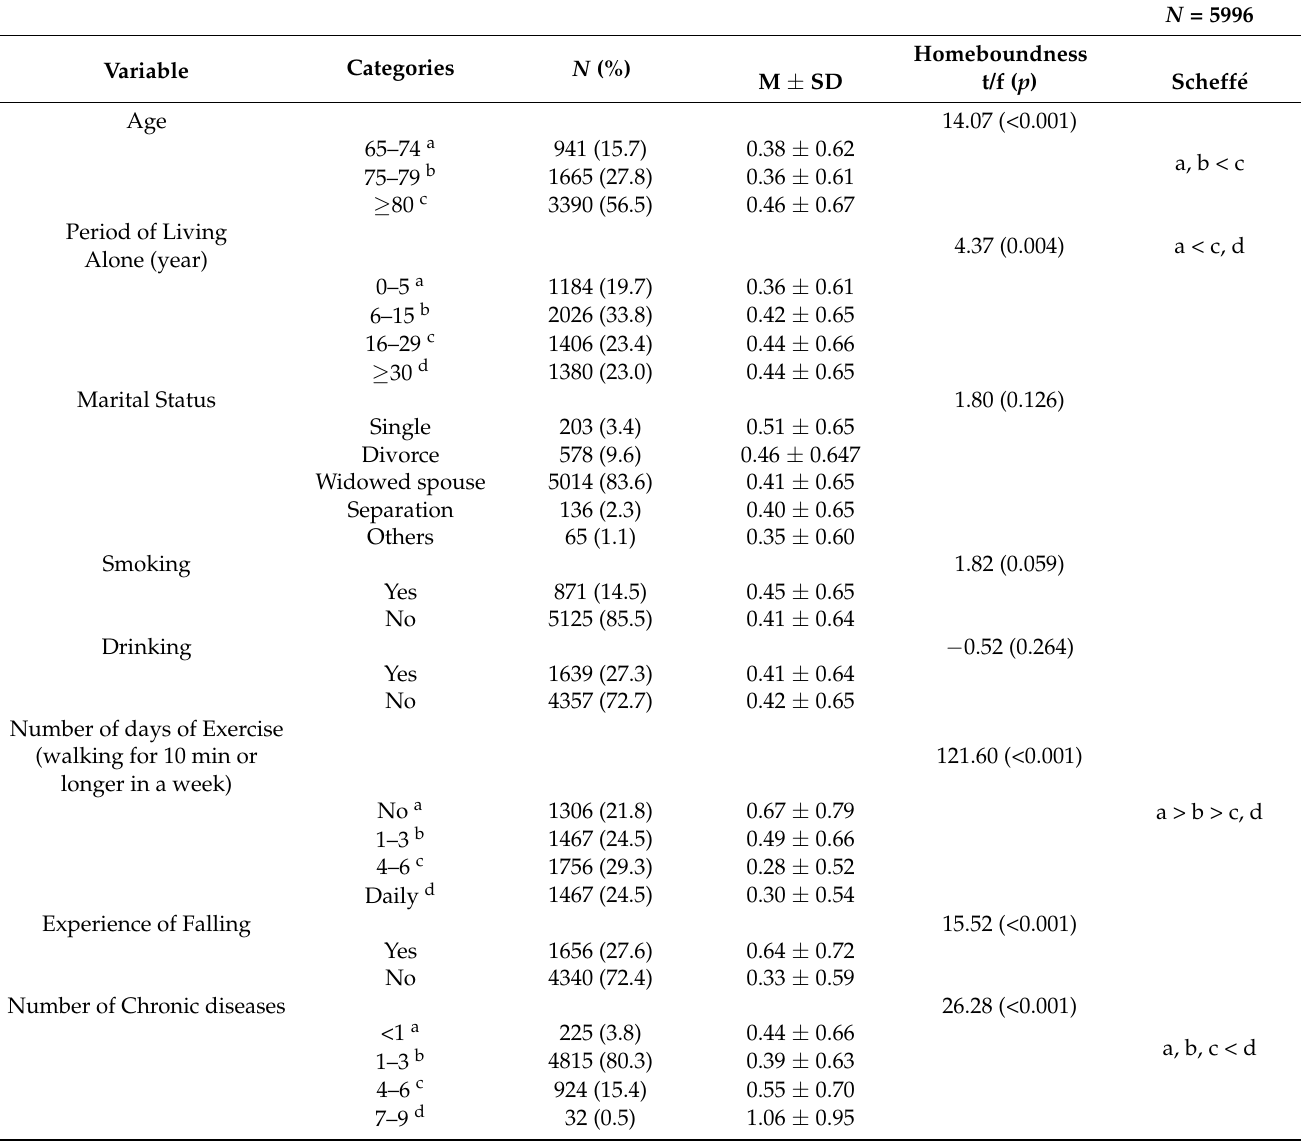
Table 2. Homeboundness status according to general characteristics, health factors, social interaction, and depression of elderly living